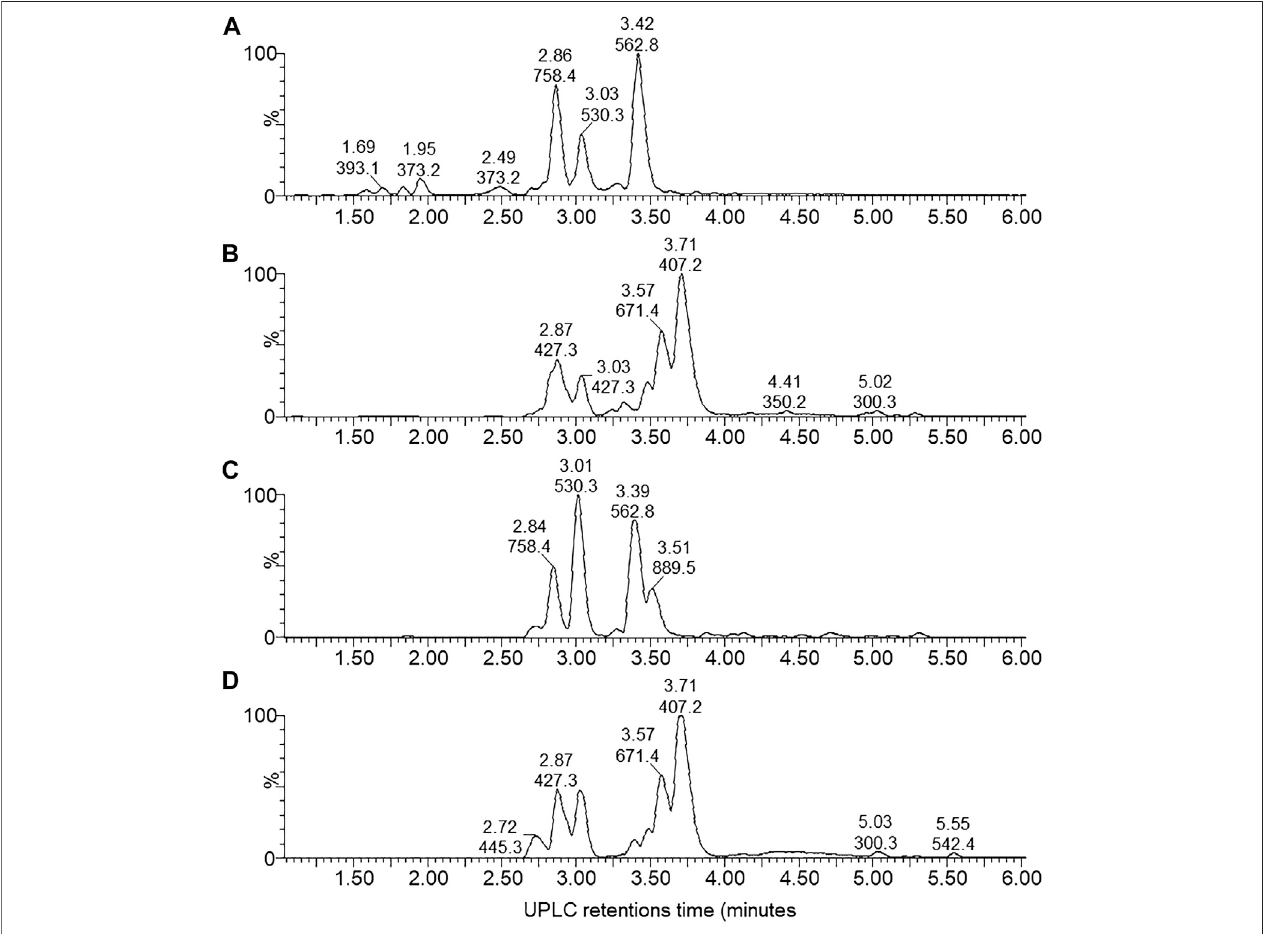
FIGURE3| UPLC-MSoftheearlyelutingcomponents(0 – 6 min)fromthefour X.khoisanae J194extractsthatshowedantibacterialactivity: (A) aqueousfractionof non-aerated broth culture, (B) NAO fraction of non-aerated broth culture, (C) fraction from aerated broth culture and (D) extract from culture grown on surface of solid medium. The masses in the spectra are protonated masses of the most prominent detected compounds.